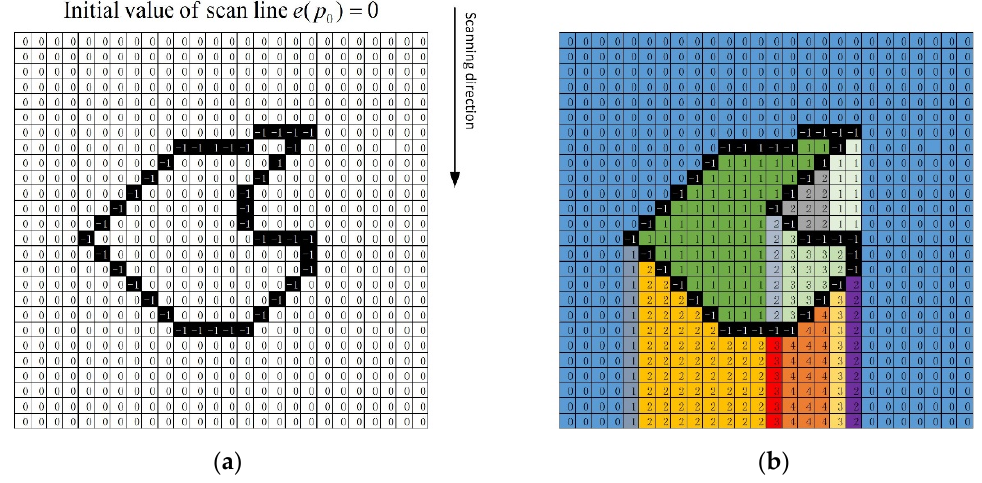
Figure 3. An example of the scan process in the vertical direction. ( a ) Binary edge map; and ( b ) the encoded result of ( a ). The black region is the edges, and each color represents a homogeneous re- gion.